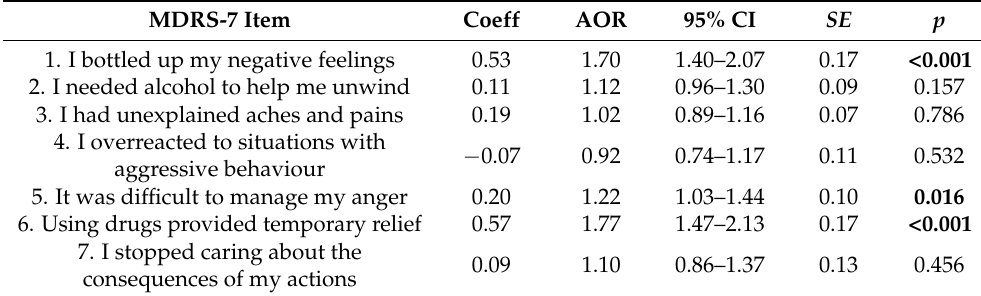
Table 5. MDRS-7 items predicting recent suicide and self-harm ideation ( n =